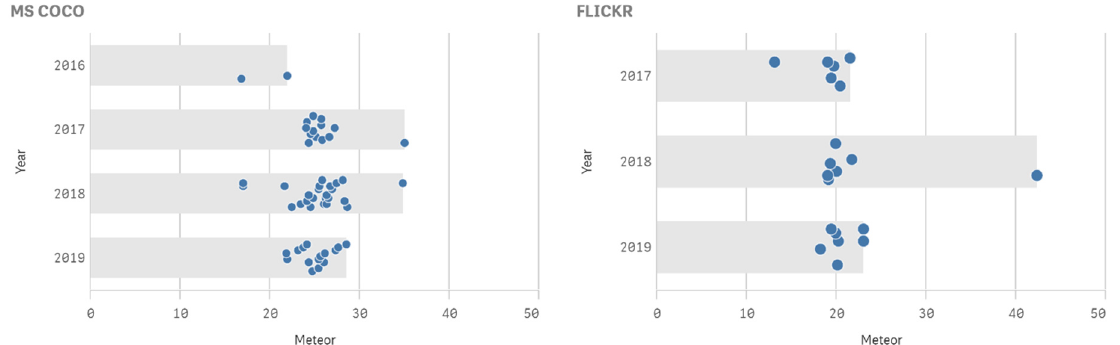
Figure 6. Meteor results by year on MSCOCO ( left ) and Flickr30k ( right ).